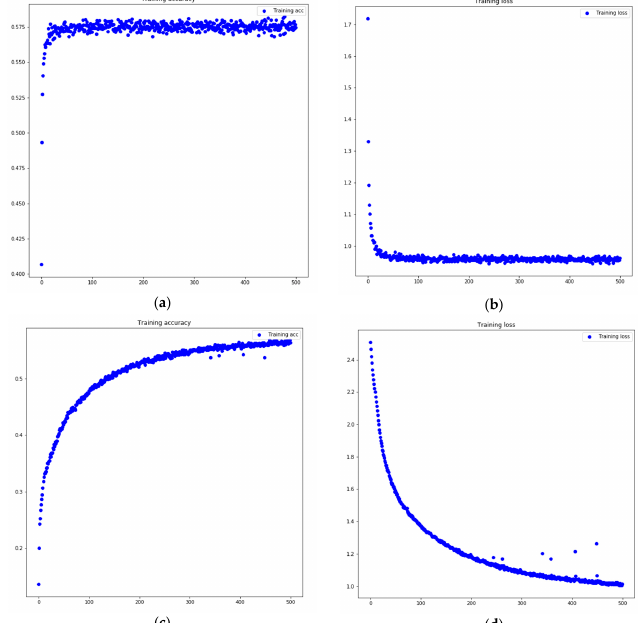
Figure 7. Training accuracy and loss plots of the DNNs with different structures. The X axis of all plots shows the number of epochs, while the Y axis show the loss or accuracy value that reached the trained model. Training accuracy and loss plots of DNN-1: ( a ) Accuracy values obtained in every epoch at training time and ( b ) loss values obtained in every epoch at training time. Training accuracy and loss plots of DNN-4: ( c ) Accuracy values obtained in each epoch at training time and ( d ) loss values obtained in each epoch at training time. However, both DNN-3 and DNN-4 took a longer amount of epochs to reach the highest accuracy value, as well as the lowest loss value, as shown in Figure 7c,d. As it progressively reached more optimal values, it did not reach the best values until at least 450 epochs. DNN-1 was used to extract the time series of organism abundance, that is, it was used to detect, classify, and count animals in a short period of time in order to compare that result with the ground truth. This was performed on images not used during the training and test phase, corresponding to the period from 17 November 2017 to 22 November 2017. Figure 8 shows three different time series for the rockfish, shrimp, and starfish during that period of six days, which covers 80 images. The classifier detected rockfish in 27 images, whereas with the manual detection, animals were detected in 24 images, which means that there are at least three false positives. In the other time series, the difference is much higher.